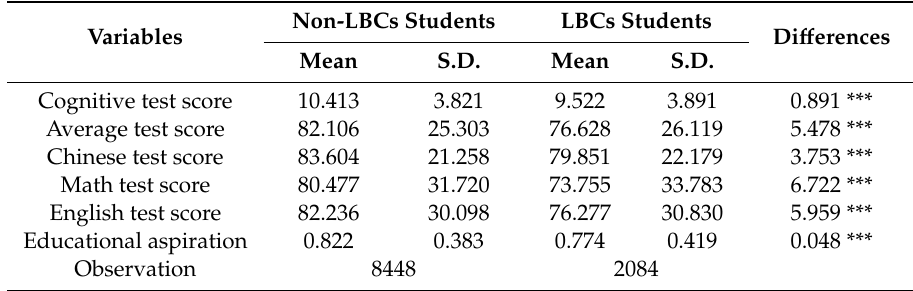
Table 2. Summary statistics of the outcome